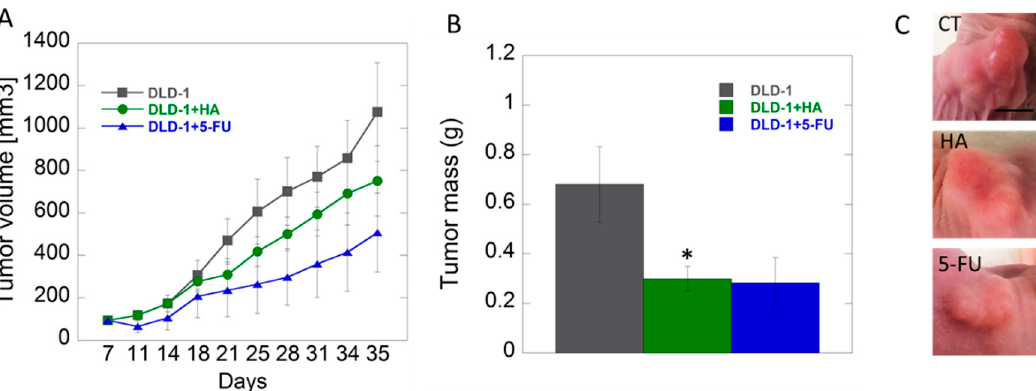
Figure 4. Analysis of tumor volume (panel A ) and tumor mass (panel B ) changes in study groups (control–DLD-1, HA-1 mg/kg body weight, DLD-1+5-FU); example images of tumors ( C ), scale bar = 0.5 cm * p < 0.05 vs. control.